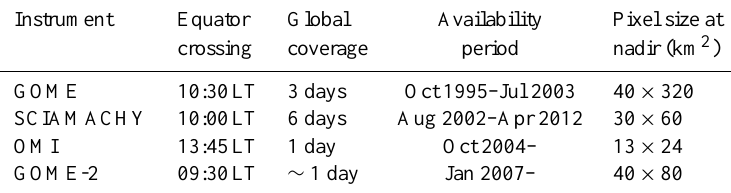
Table 1. Characteristics of the four satellite platforms used in this